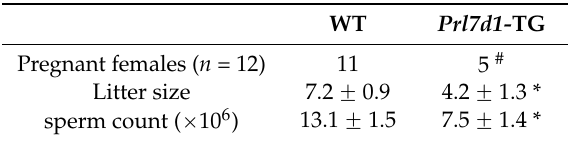
Table 1. Fertility and sperm counts of 4-month-old Prl7d1 transgenic ( Prl7d1- TG) and wild-type (WT) mice ( n = 6).